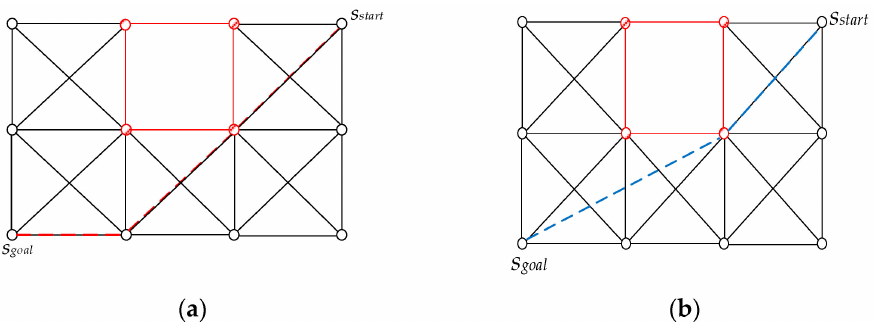
Figure 11. Comparison of the expected path of A* algorithm and actual shortest path. ( a ) A* algorithm-based route planning and ( b ) True shortest